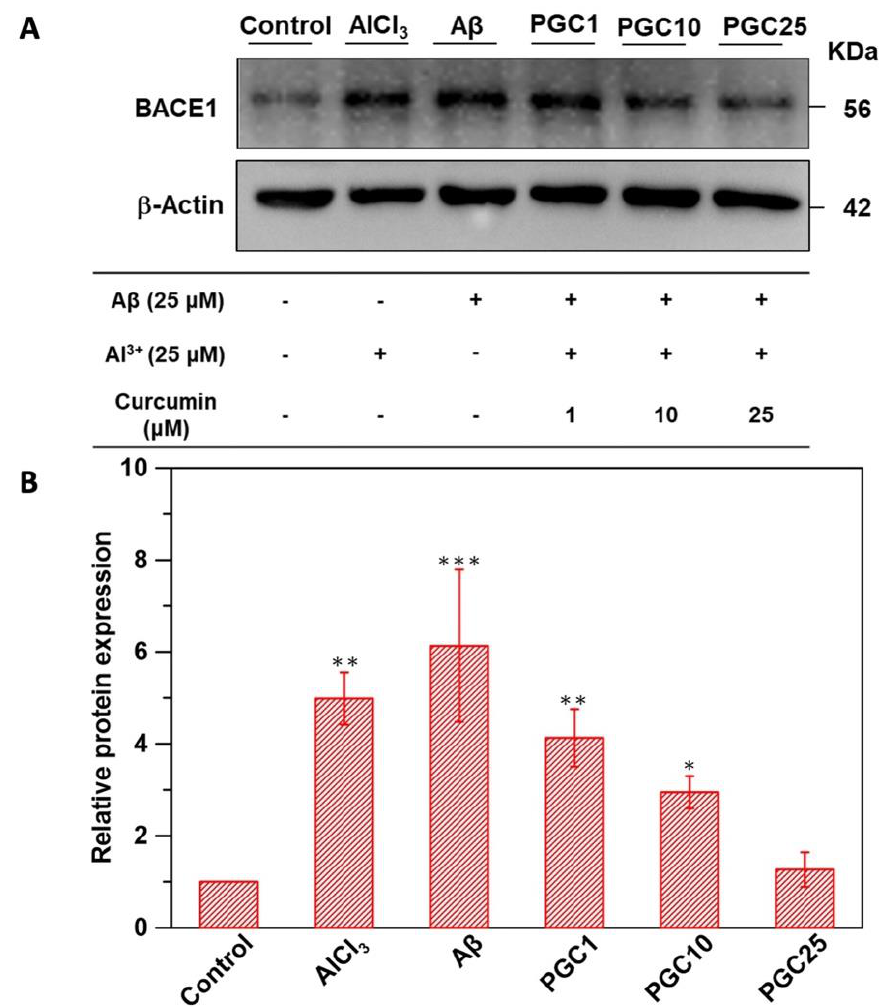
Figure 5. Biochemical analysis. ( A ) The western blot analysis of BACE1. β -actin was used as the loading control. ( B ) The quantitative values of the BACE1 expression data obtained the ratio of BACE1 protein/actin protein band intensities normalized to 1 in the control group ( n = 6, * p < 0.05 compared with control, ** p < 0.01 compared with control, *** p < 0.001 compared with control).